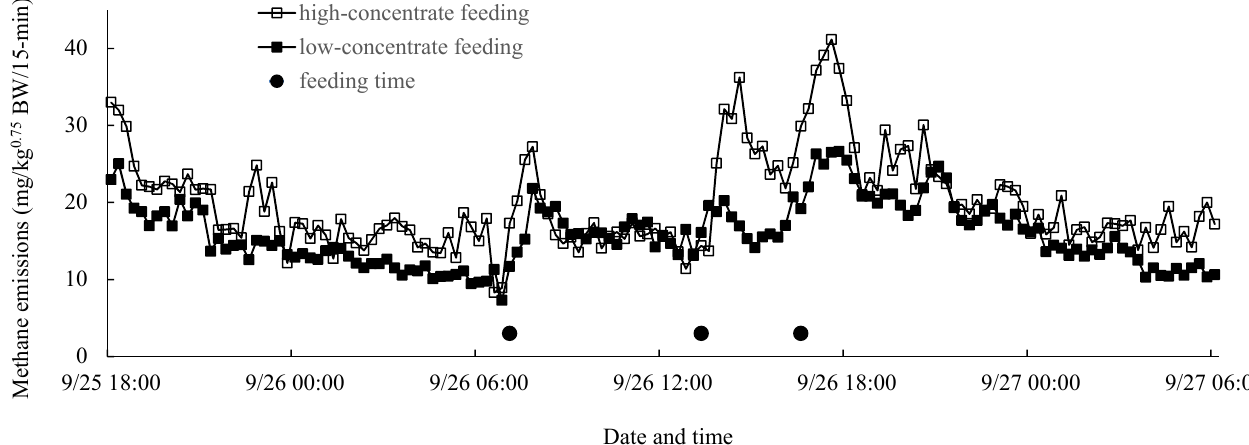
Figure 1. Methane emissions of Simmental crossbred beef cattle in respiration chambers, as determined by infrared-absorption-based gas ana- lyzer (Exp 1). □ , cow (body weight, 224 kg) fed high-concentrate diet; ■ , cow (body weight, 260 kg) fed low-concentrate diet; ● , feeding time. Meth- ane emissions increased immediately after feeding.